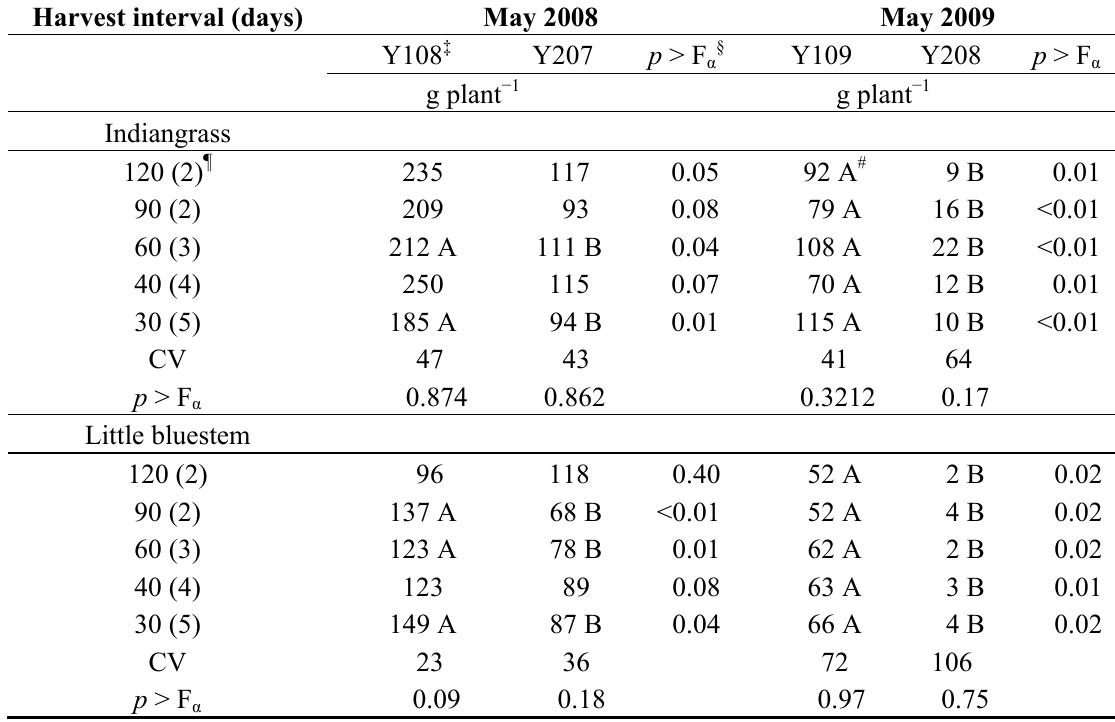
Table 2. Effects of harvest interval and harvest-duration on recovery of indiangrass ( Sorghastrum nutans ) and little bluestem ( Schizachyrium scoparium ) plants in mixed native grass stands † in mid-May of succeeding two consecutive